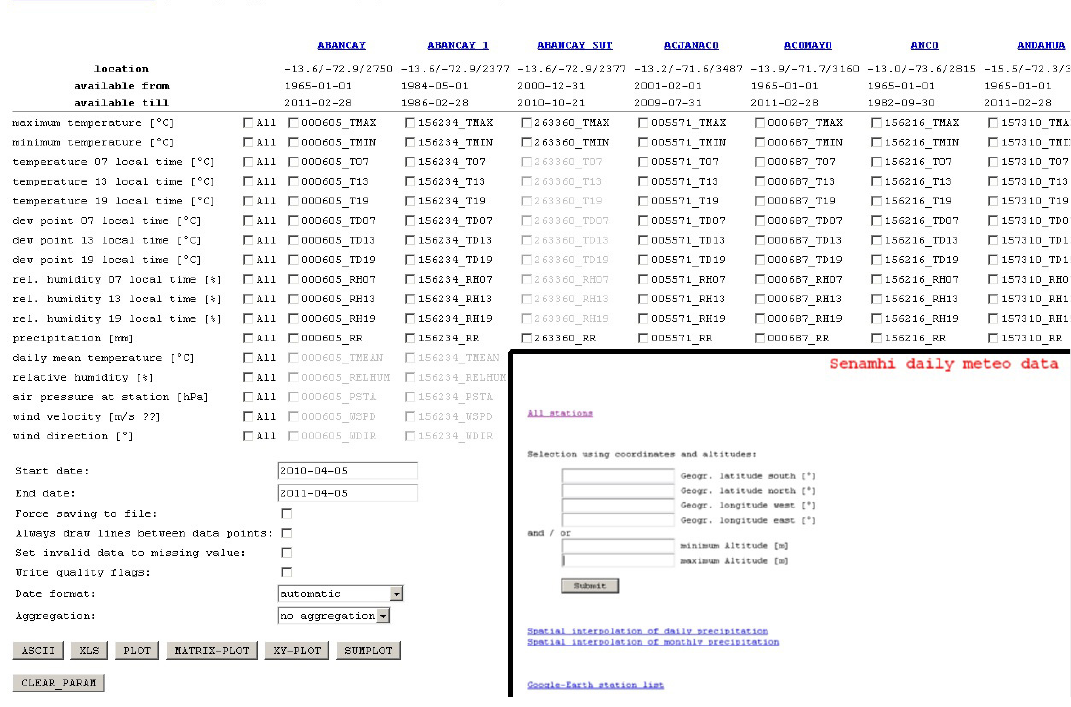
Figure 3. Data portal of the PACC project with the possibility of pre-selecting stations by a geographical criterion, as a latitude-longitude and / or an altitude range (lower right corner). In the main screen of the data portal, a station-parameter combination can be selected for download, analysis or graphical representation of meteorological data.